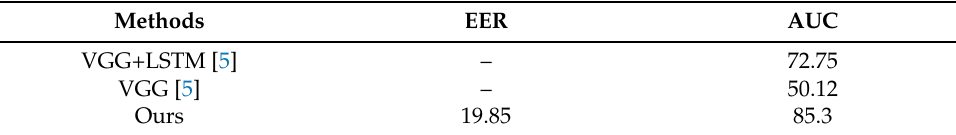
Table 2. EER and AUC for frame-level comparisons on